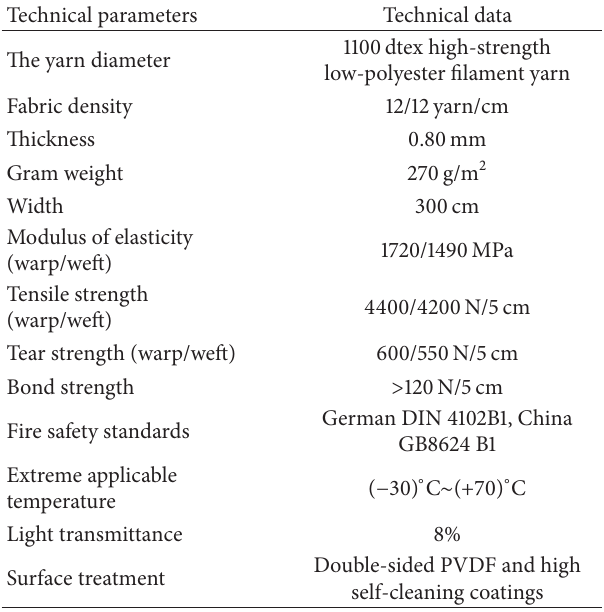
Table 1: The material parameters of the Heytex H5573 membrane.